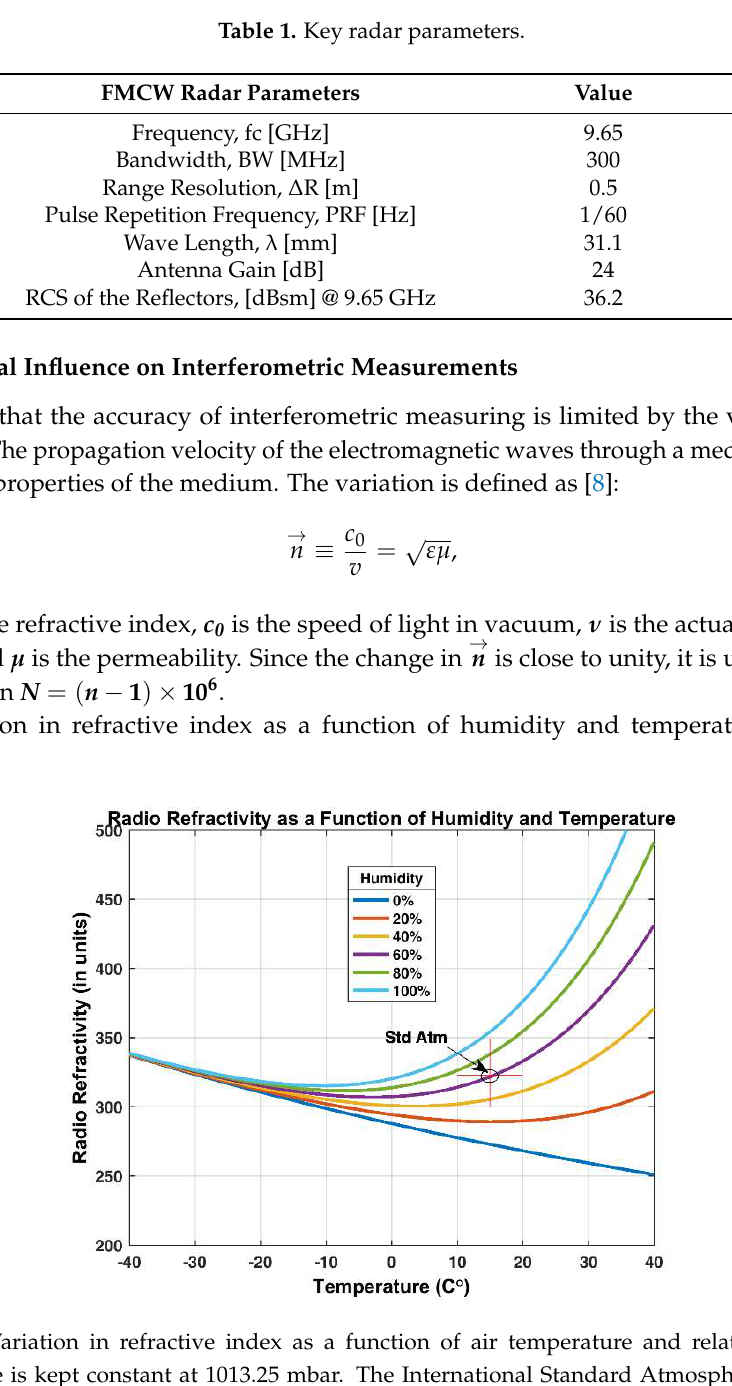
Table 1. Key radar parameters.